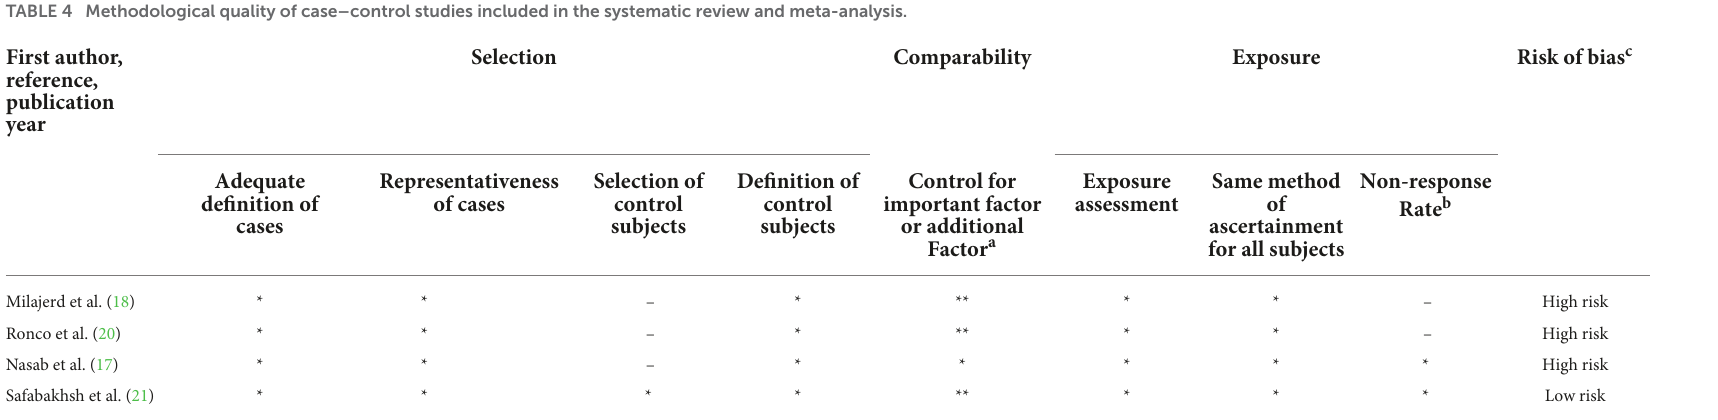
TABLE 4 Methodological quality of case–control studies included in the systematic review and